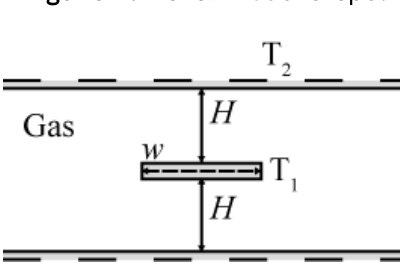
Figure 4. Planar model